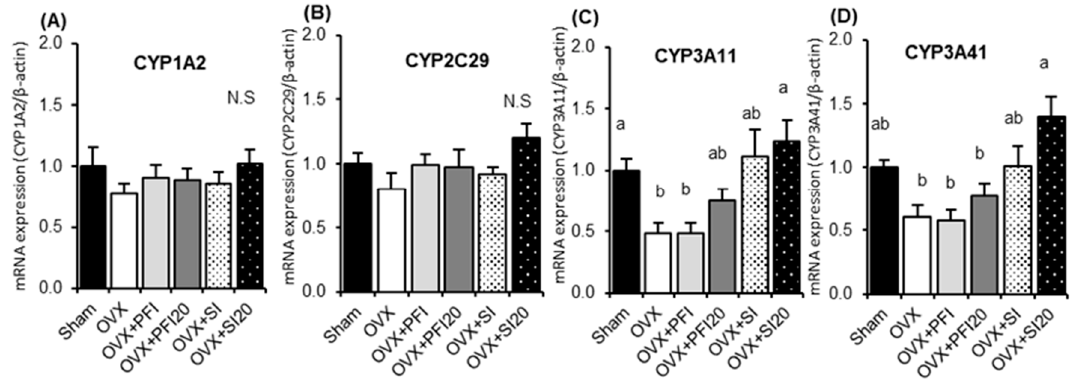
Figure 3. Hepatic mRNA expressions of ( A ) CYP1A2, ( B ) CYP2C29, ( C ) CYP3A11 and ( D ) CYP 3A41 in